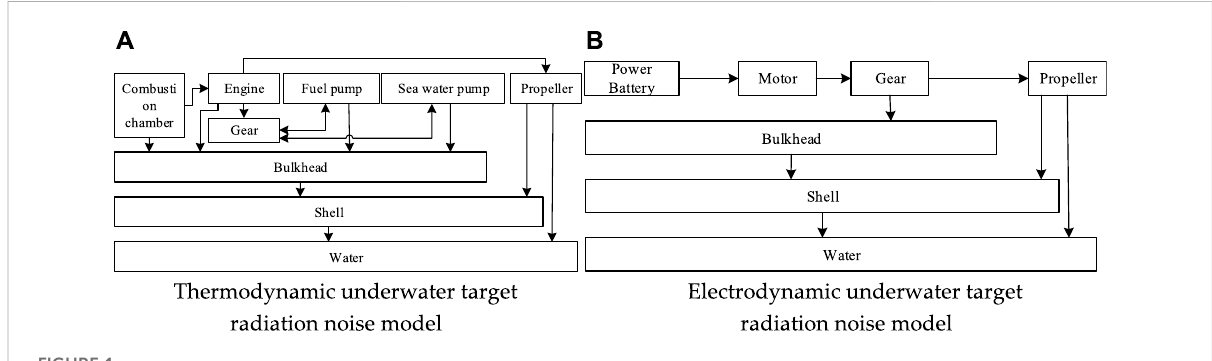
FIGURE 1 Two types of underwater target radiation noise generation models.